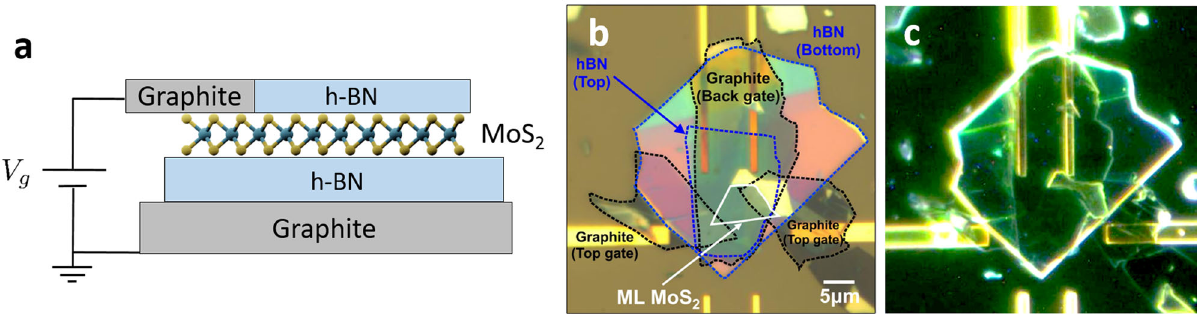
Fig. 1 Charge tunable device based on a MoS 2 monolayer. a Schematic side-view of the sample. The MoS 2 monolayer is encapsulated between two thin h-BN fl akes to provide high optical quality and to prevent photodoping effects. Thin graphite fl akes were used to provide an electrical control, via the gate bias voltage V g , of the resident carrier concentration in the monolayer. The whole heterostructure is deposited onto a silicon substrate with a 90 nm-thick silicon dioxide layer on top of which gold lines were deposited lithographically prior to the mechanical exfoliation. b Optical microscope image of the sample under white light illumination. c Dark- fi eld image of the sample, revealing clean interfaces with no visible bubbles after the formation of the heterostructure. The scale is the same as in panel ( b